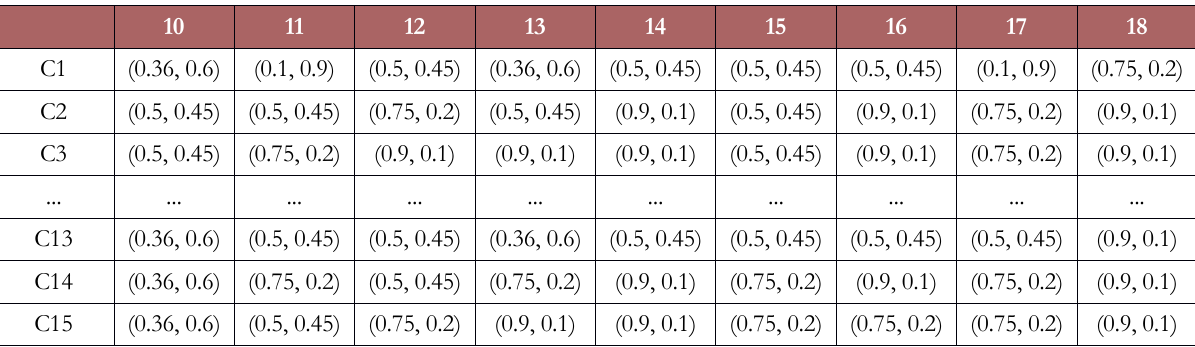
Table 5. The intuitionistic fuzzy matrix of success